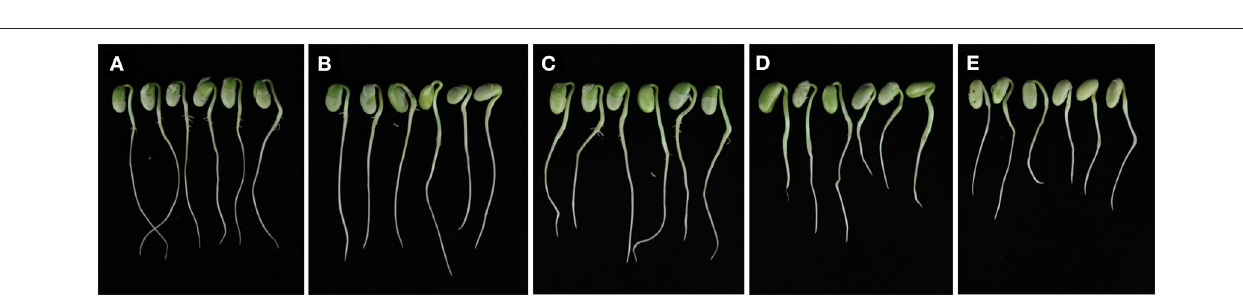
FIGURE 2 | Seed bioassay analysis of the effects of different concentrations wuyiencin on soybean seed growth. From left to right, treatments are 0 (A) , 12.5 (B) , 25 (C) , 50 (D) , and 100 (E) µ g/mL wuyiencin.